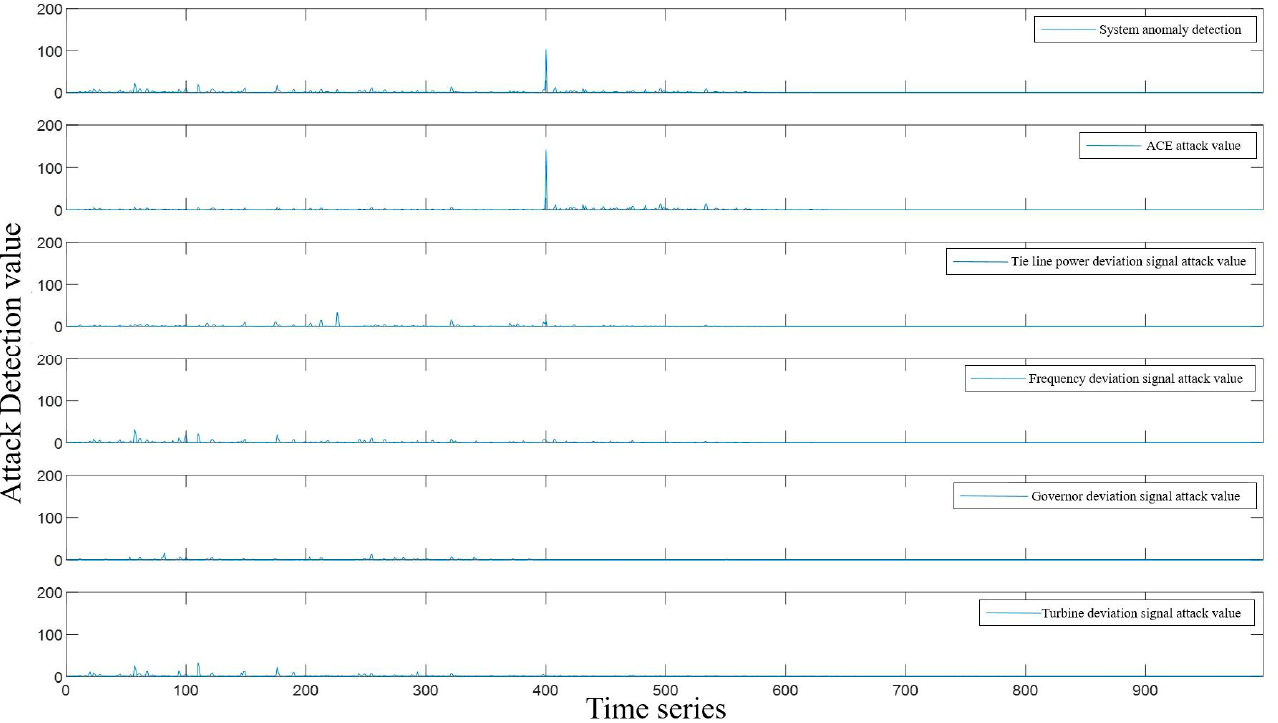
Figure 7. Quantitative Detection of Single State Variable False Data Injection Attack.